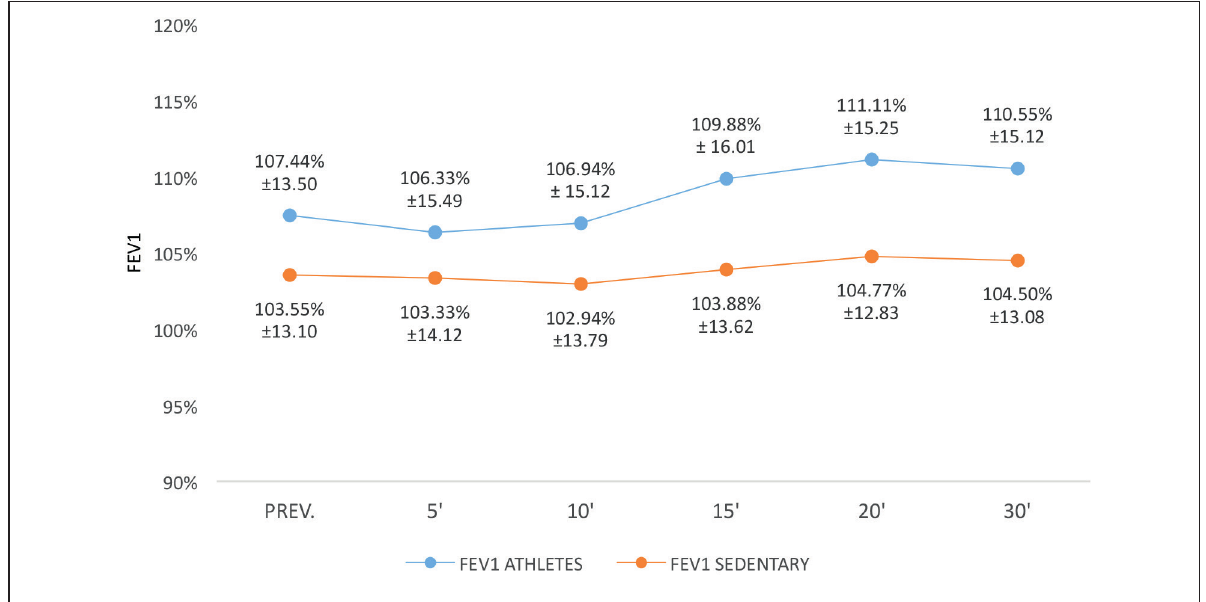
Figure 1 - Values of decrease in FEV1 in sedentary individuals and athletes pre test and 5, 10, 15, 20, and 30 minutes post EIB Note: FEV 1 (forced expiratory volume in one second), PREV (predicted value), 5 '(5 minutes), 10' ('10 mins), 15' (15 minutes), 20' (20 min- utes) and 30' (30 minutes).